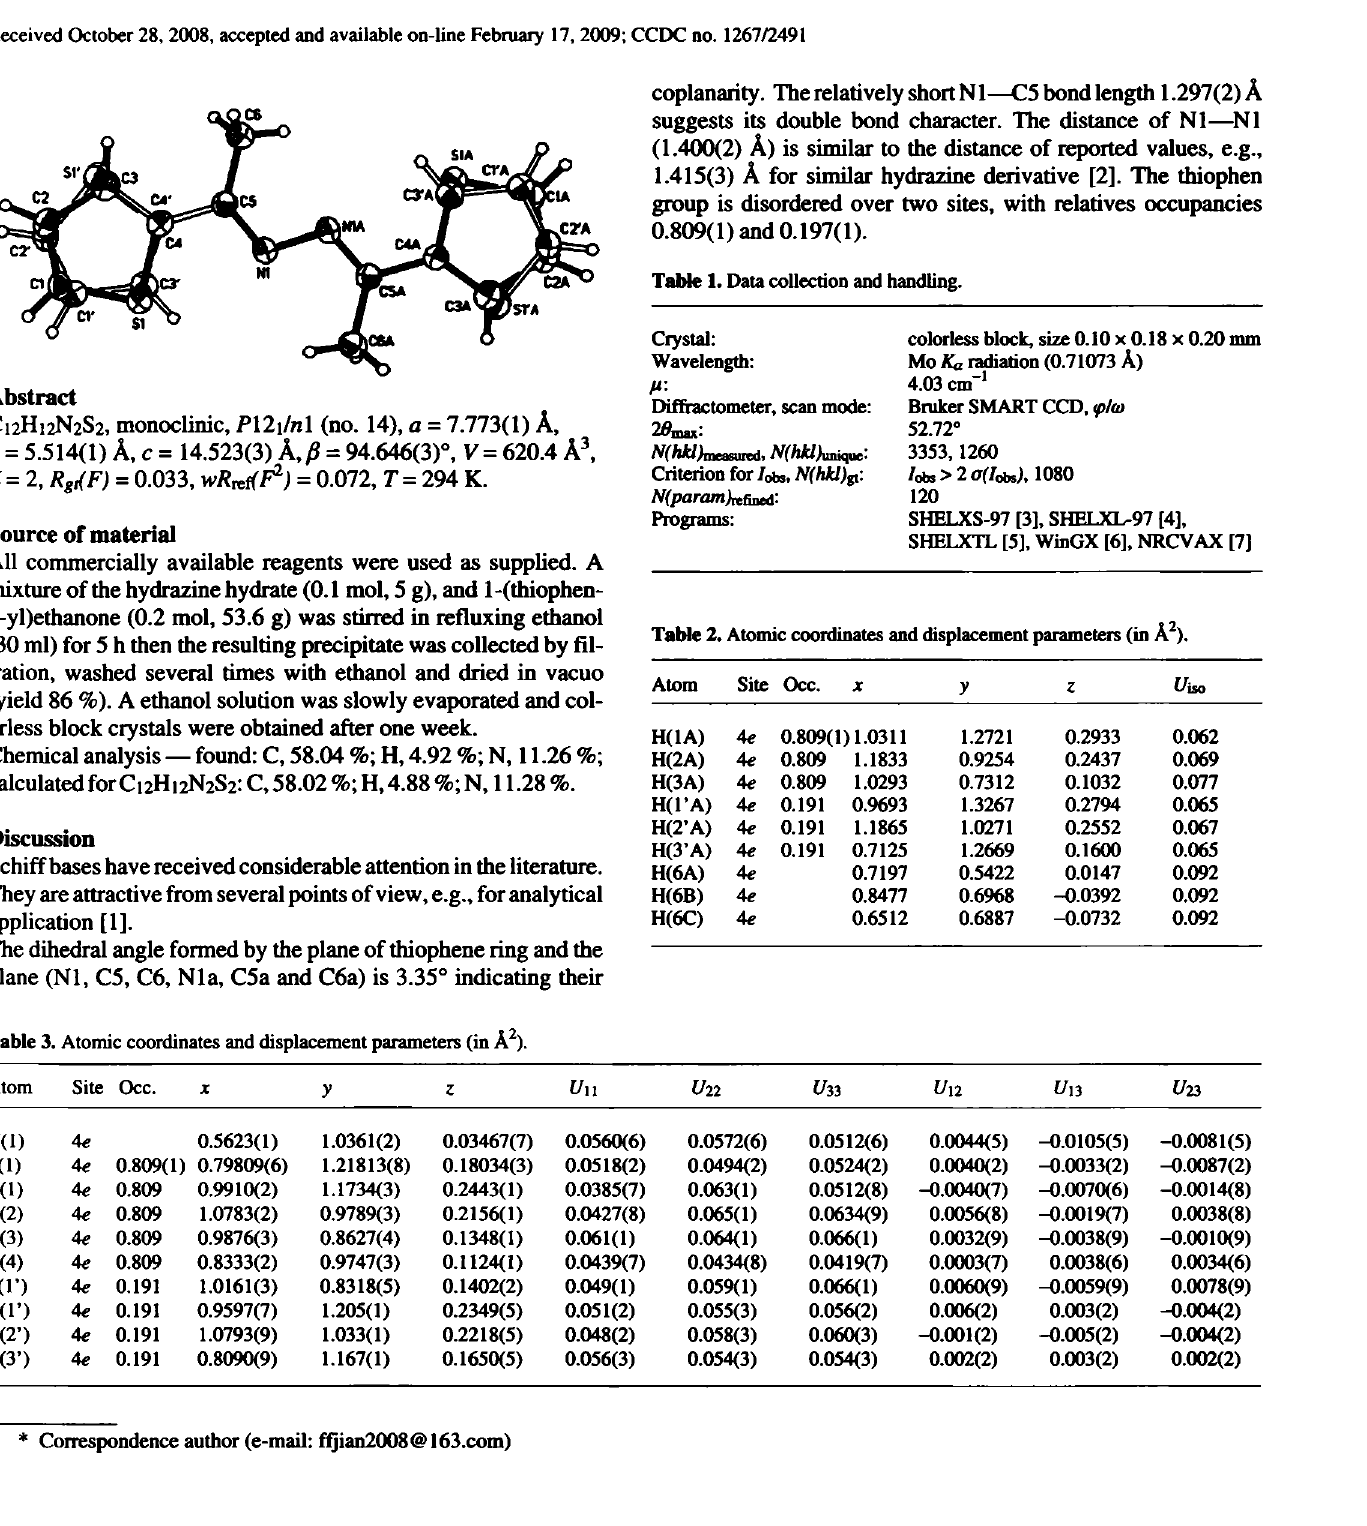
Table 1. Data collection and handling.